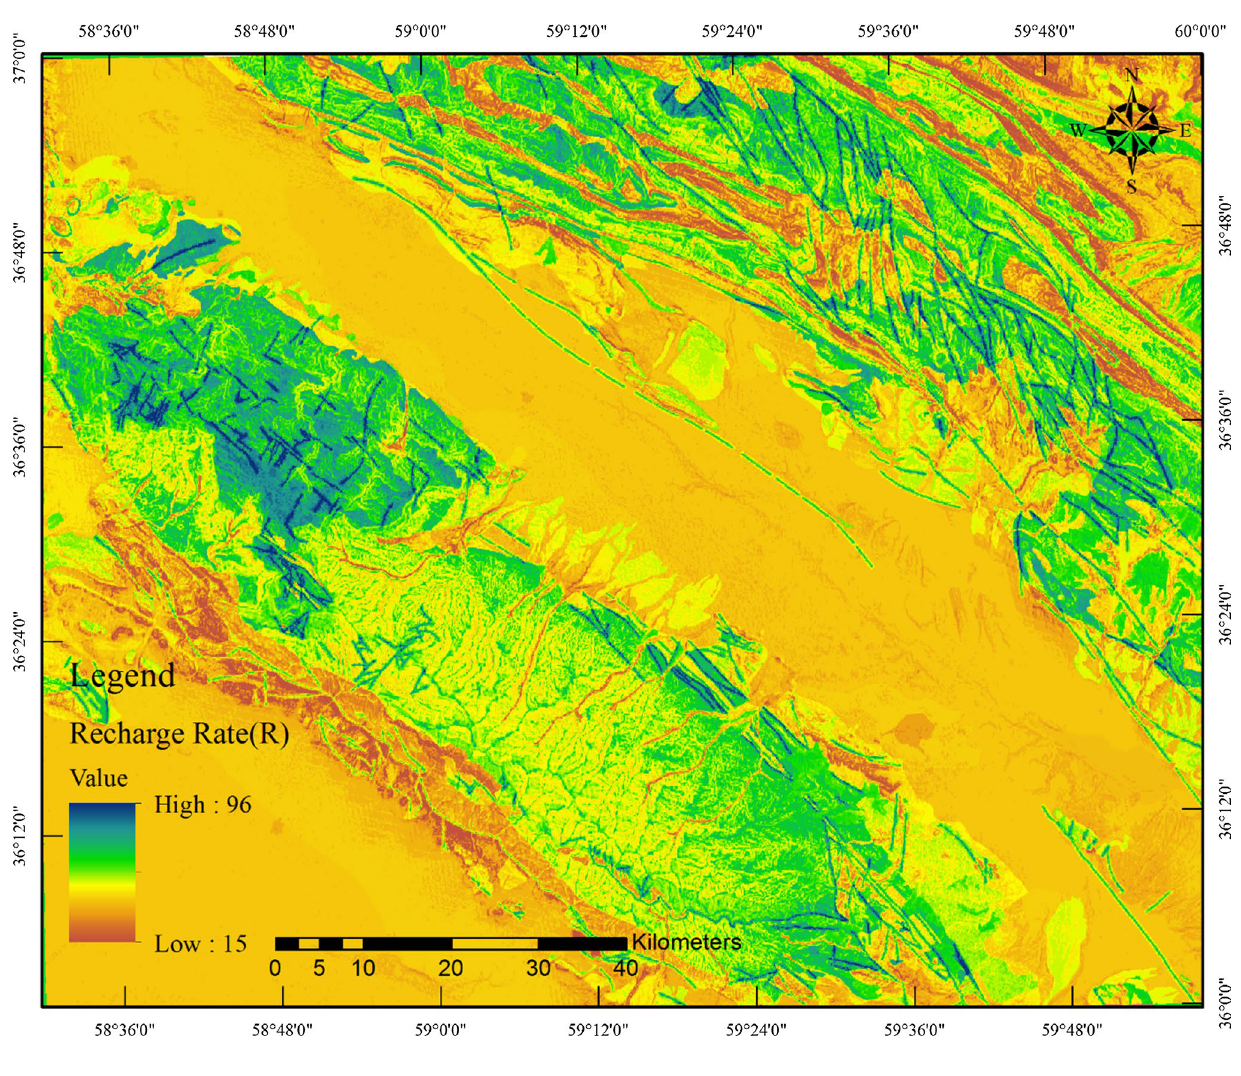
Fig. 8 Approximate recharge rate in APLIS in the area under study Table 6 Qualitative classification of recharge and spatial development of